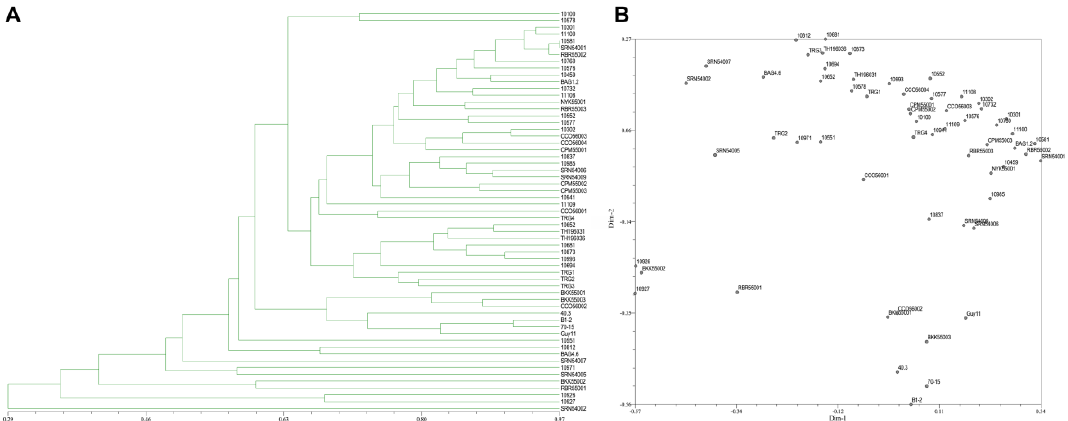
Figure 6. ( A ), Dendrogram presenting the relationship from SRAP based on UPGMA cluster analysis. ( B ), 2D principal component analysis (PCA) based on genetic relationships from SRAP data using the DECENTER and EIGEN features of NTSYSpc.